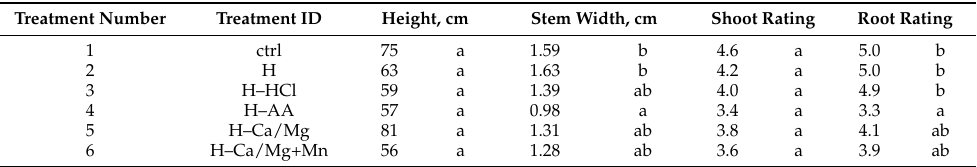
Table 5. Soybean height, stem width, and shoot and root visual ratings (scale of 0 to 5, with 0 = dead and 5 = relatively healthiest shoot/root) at 53 d (growth stage R1–R2) after planting for a hydroponic nutrition study.